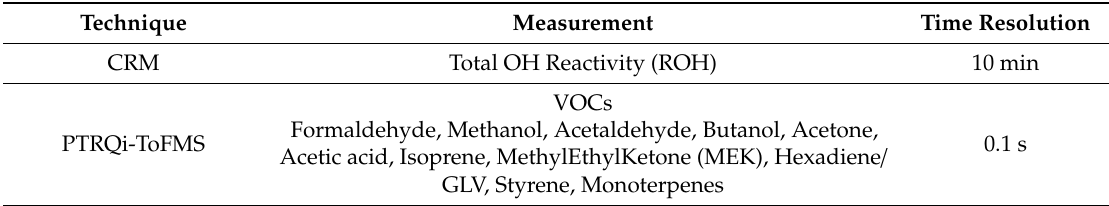
Table 1. Instruments deployed in the campaign and used for data